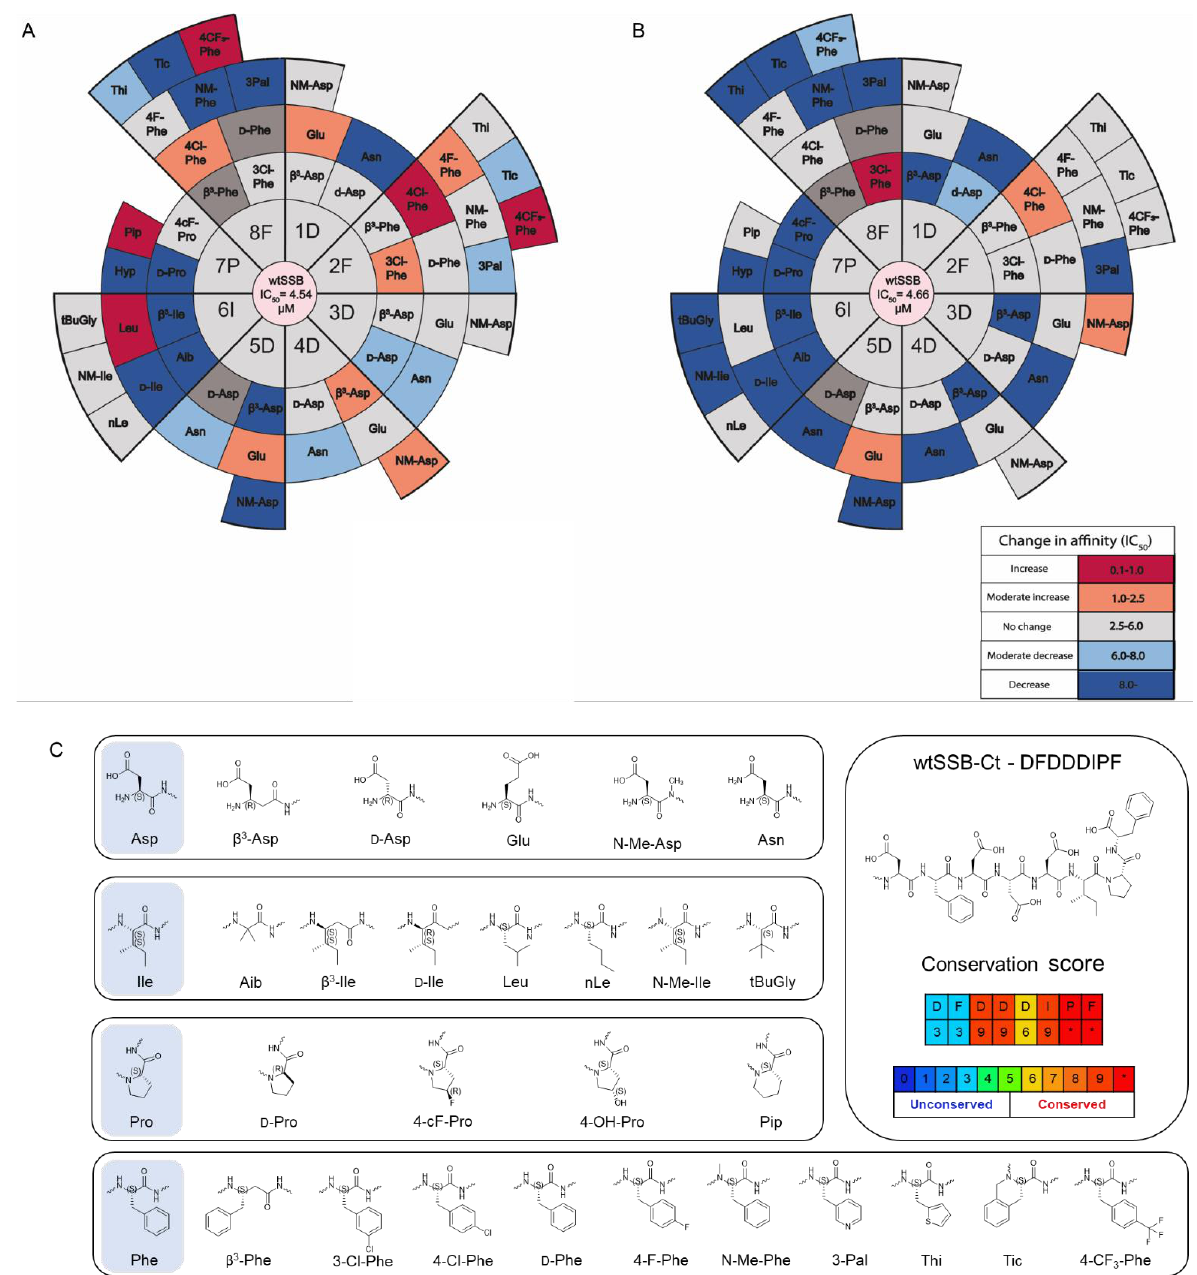
Figure 5. Screening and design of the mSSB-Ct library. Radial heat map showing competitive fluo- rescence anisotropy screening data of mSSBs on ( A ) ExoI and ( B ) RecO. IC 50 values lower than 1 µM are highlighted in red. Moderate decreases in IC 50 (1.0–2.5 µM) are shown in orange. Tolerated or non-significant changes are shown in light pink (IC 50 = 2.5–6.0 µM). Moderate or significant increases in IC 50 values (6.0–8.0 µM and >8.0 µM) are shown in light and dark blue, respectively. Modifications in dark grey were not evaluated, due to compound impurity. ( C ) wtSSB-Ct sequence, conservation score, and applied modifications for each occurring amino acid in the wtSSB-Ct sequence [21], * denotes the highest